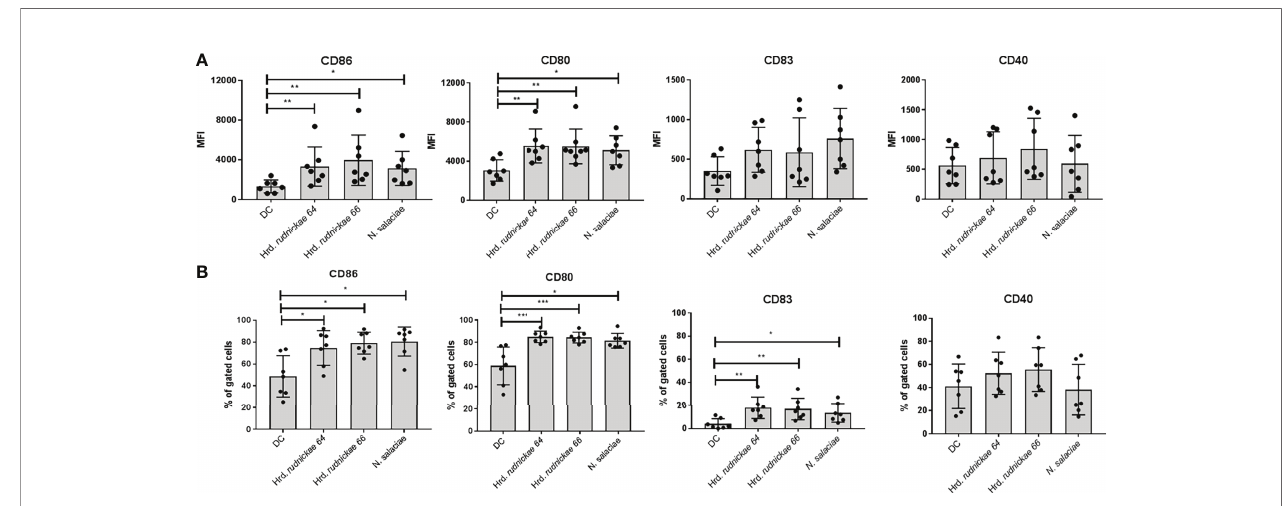
FIGURE 1 | Surface marker expression on human DCs stimulated with halophilic archaea. Human DCs from healthy blood donors were stimulated for 24h either with Hrd. rudnickae 64 , Hrd. rudnickae 66 , N. salaciae or were left unstimulated (DC). Fluorescence intensity is expressed as MFI (once for each donor) of CD86, CD80, CD83 and CD40 surface expression on DC, from which the MFI obtained with an isotype-matched antibody was subtracted (A) and the percentages of positive cells with the CD86, CD80, CD83 and CD40 expression on DC surface (B) were calculated. Data shown represent the means ± SD of 7 independent donors. Statistical analyses were performed using the Mann – Whitney U test for unpaired data. *p < 0.05; **p < 0.01; ***p < 0.001 versus control (unstimulated